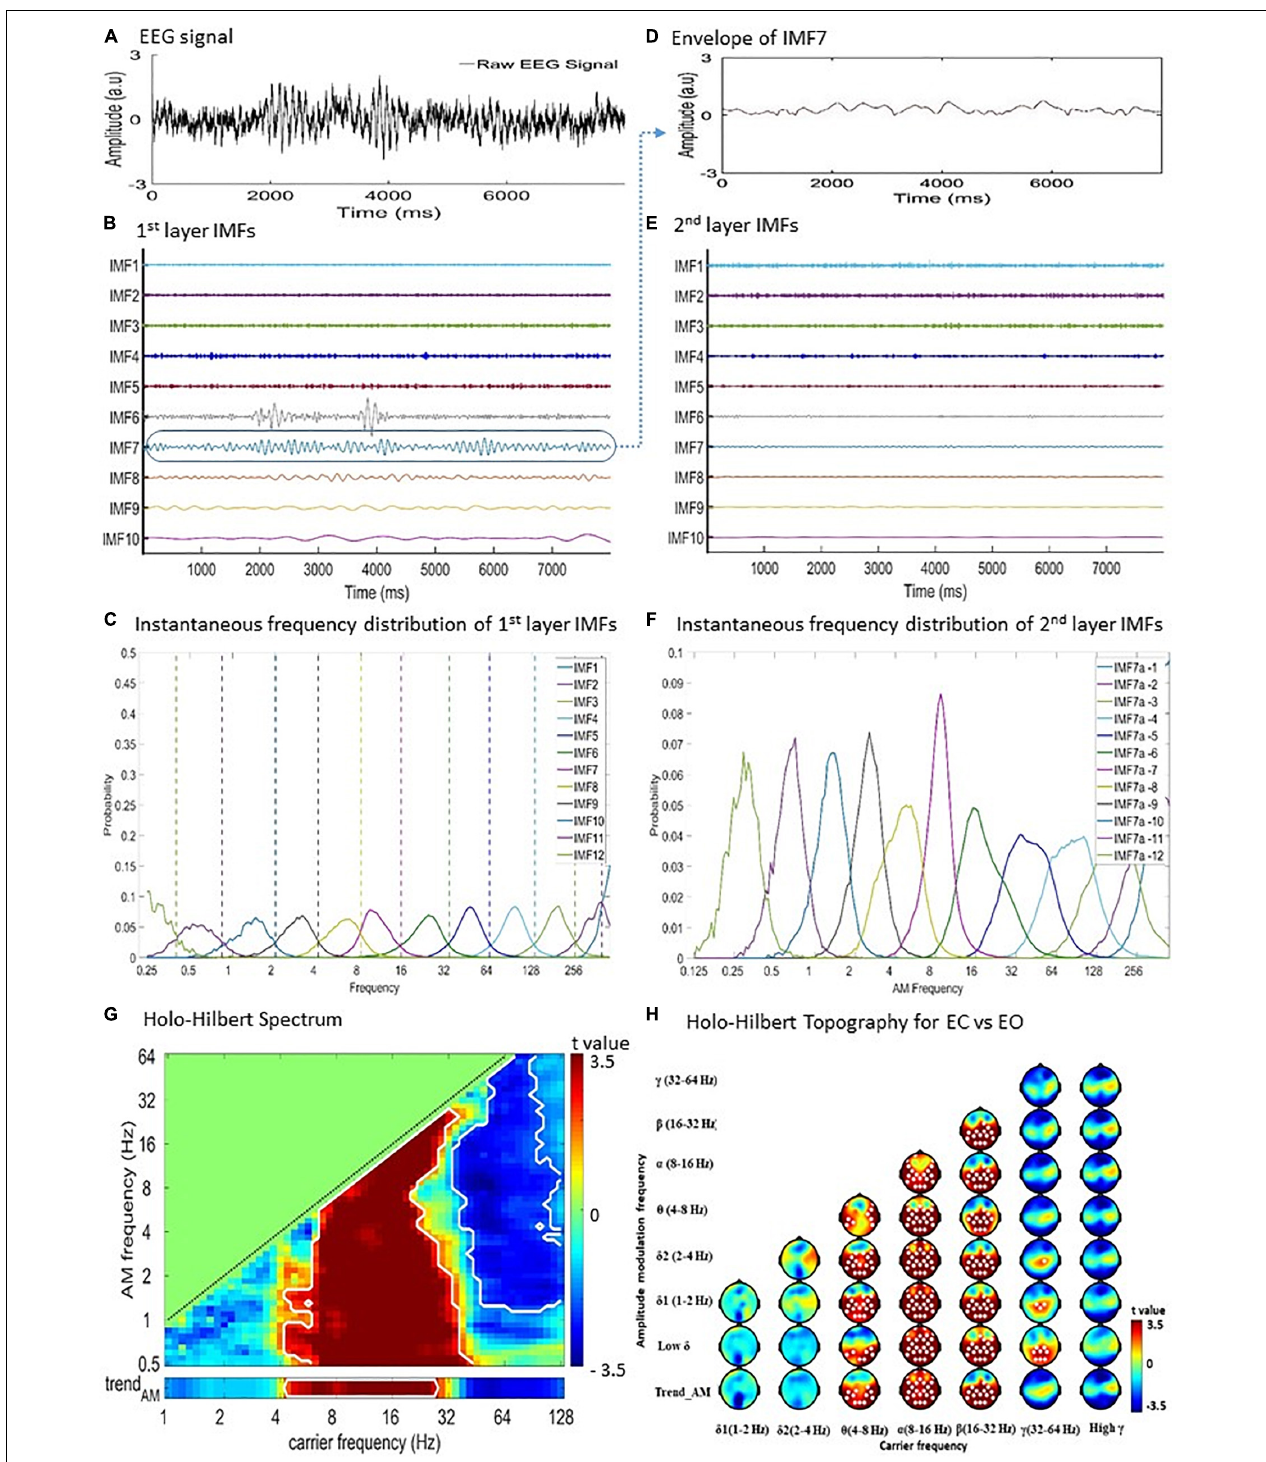
FIGURE 1 | Holo-Hilbert Spectral Analysis (HHSA) for the EEG recordings. Diagram of two-layer ensemble empirical mode decomposition (EEMD) of resting EEG data. (A) Raw EEG signal from a single subject at a single channel. (B) The first layer EEMD decomposes the raw signal into 12 intrinsic mode functions (IMFs). (C) The instantaneous frequency distribution of first layer IMFs denoting the frequency ranges represented by each IMF. (D) To illustrate the second layer EEMD, the envelope of IMF7 was extracted. (E) Subsequent application of EEMD on the IMF7 envelope produces the second layer IMFs. (F) Instantaneous frequency distribution of the second layer IMFs designating the frequency ranges represented by each IMF. (G) Holo-Hilbert spectrum of the carrier wave modulated by the envelopes. (H) Summated topographical maps of AMs of the carrier wave (0.5–64 Hz) by envelopes (1–128 Hz) frequencies. EC, eye closing; EO, eye opening.